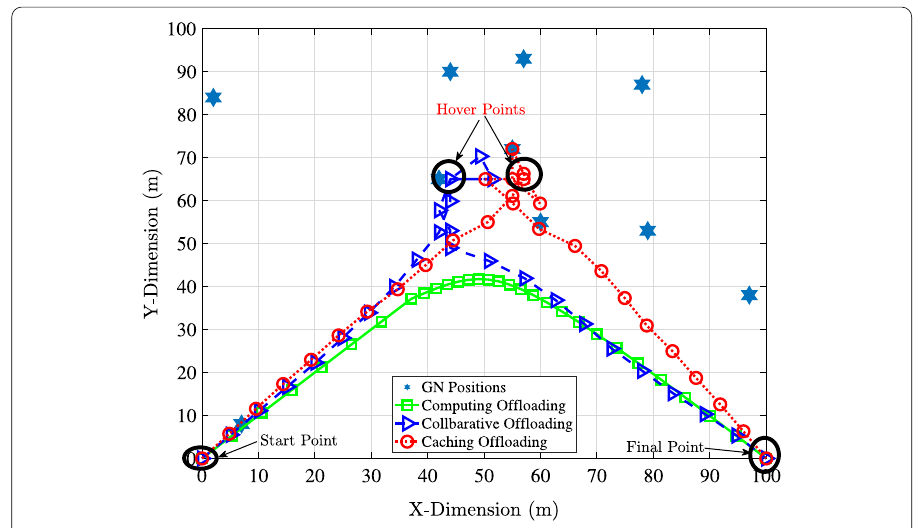
Fig. 2 The UAV trajectories w.r.t. different offloading schemes when τ = 0.5